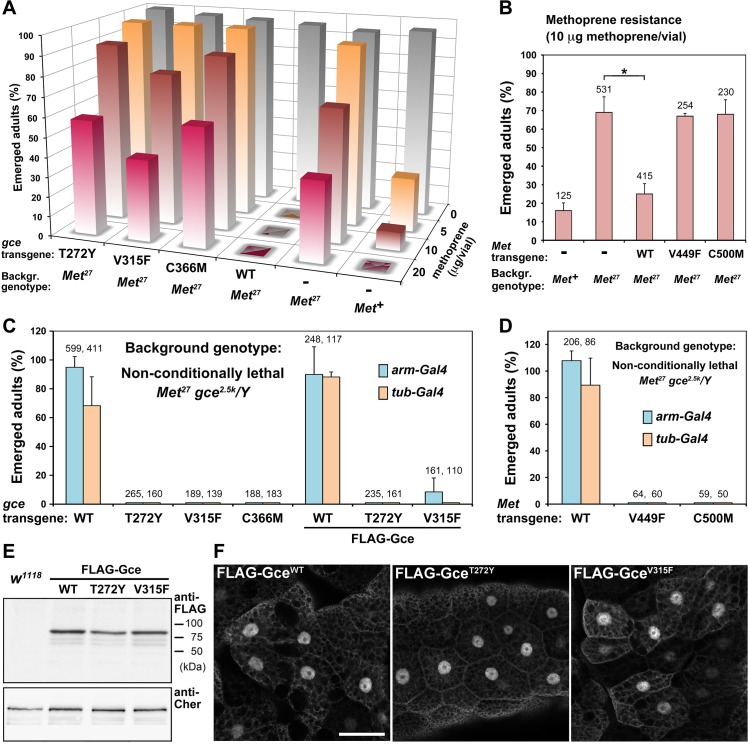
The capacity to bind JH is essential for Gce/Met function in vivo.(A-B) Met
27 mutants tolerate methoprene better than Met
+ control flies [47] or Met
27 flies expressing transgenic GceWT or MetWT proteins. Met
27
/Y males carrying the indicated UAS-gce or UAS-Met transgenes were mated to Met
27
; arm-Gal4 females, and the F1 progeny was fed methoprene. In the presence of methoprene, GceWT totally blocked adult development and MetWT significantly (*; P < 0.0003) reduced survival relative to the Met
27 strain, whereas mutated Gce or Met did not have this effect. Values are per cent average numbers of emerged adults relative to total numbers of pupated animals. Each column represents 200–430 animals (or the indicated numbers in B) counted in 2–3 independent trials. (C-D) Balanced Met
27
gce
2.5k
/FM7c; arm-Gal4 (or tub-Gal4) females were crossed with males bearing the UAS-gce or UAS-Met transgenes, and emerged Met
27
gce
2.5k
/Y adult males were scored relative to their FM7c/Y (Met
+
gce
+) siblings (1:1 ratio was considered 100% rescue). Non-conditionally lethal Met
27
gce
2.5k
/Y males were rescued to adulthood by transgenic GceWT, FLAG-GceWT, and MetWT proteins but not by their mutated versions except for a few flies rescued by one randomly inserted FLAG-GceV315F construct expressed under arm-Gal4 (C). Data are mean ± SD; numbers of all scored F1 males are given above columns. (E) FLAG-Gce WT and mutated proteins were stable when expressed in vivo as shown on an immunoblot (anti-FLAG antibody) from adult flies. The Cheerio (Cher) protein served as a control. (F) FLAG-Gce WT and mutated proteins were detected with the anti-FLAG antibody in the nuclei of larval fat body cells. Bars, 50 μm.